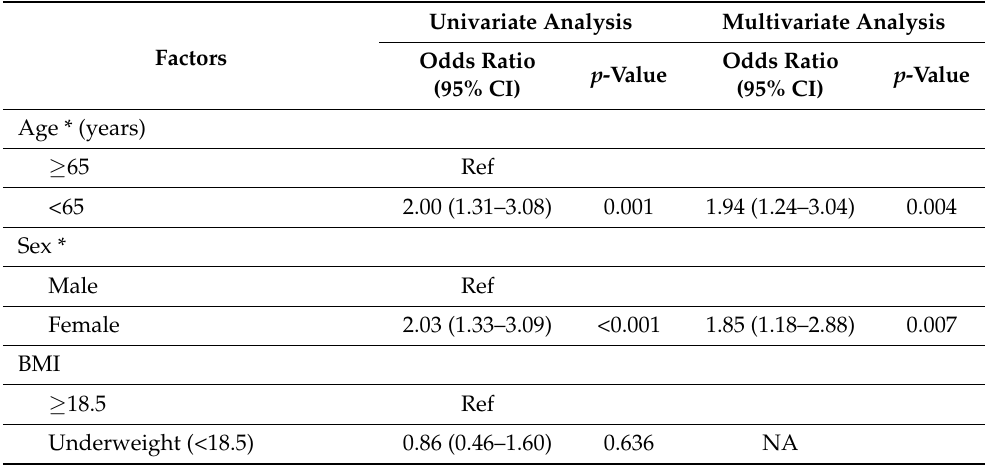
Table 5. Factors associated with systemic adverse events following the booster dose with the mRNA